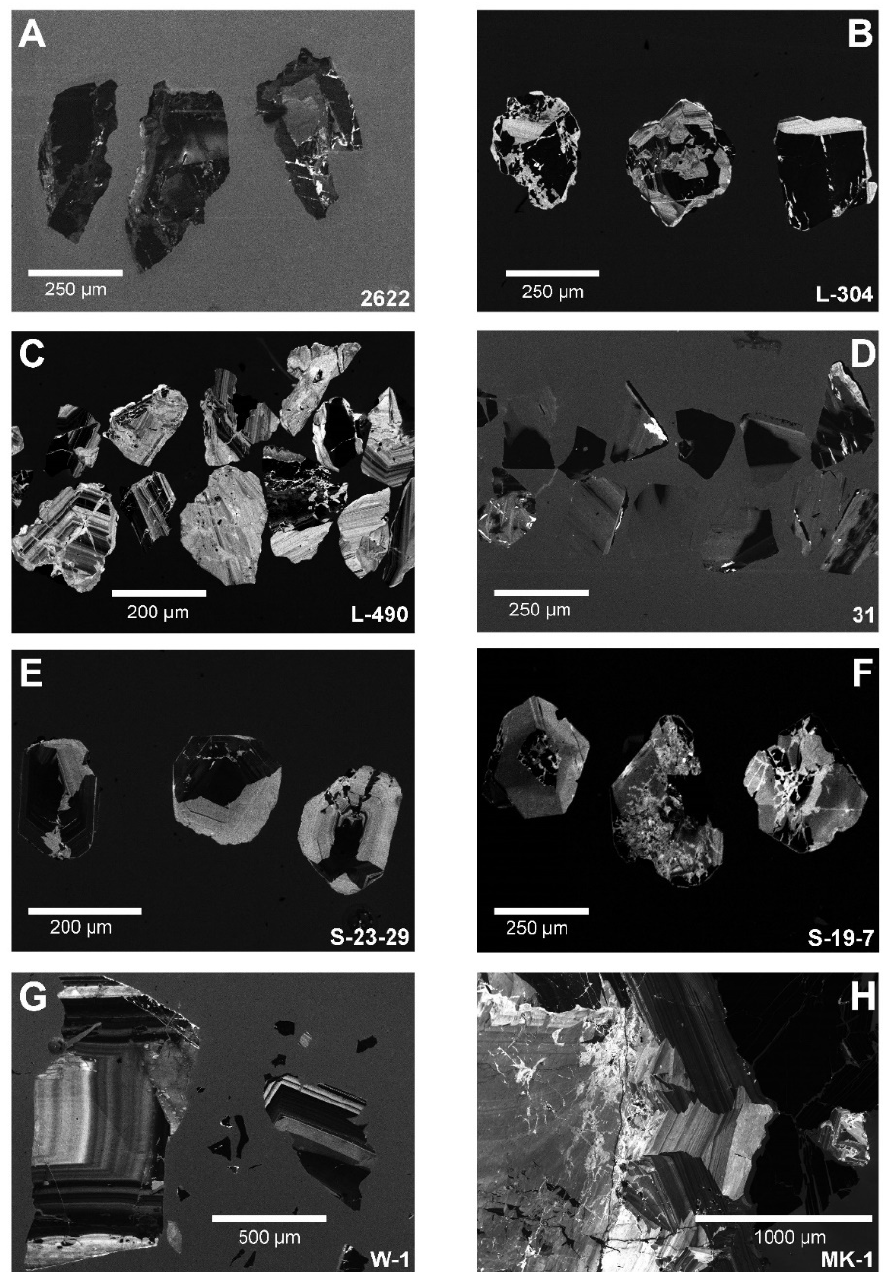
Figure 8. Representative scanning electron microscope (SEM) cathodoluminescence (CL) images of cassiterite grains used for Pb-Pb and U-Pb dating: ( A ) 2622 (East Sayan pegmatite belt, Vish- nyakovskoe deposit). CL imaging reveals a combination of both sector and faint oscillatory zoning